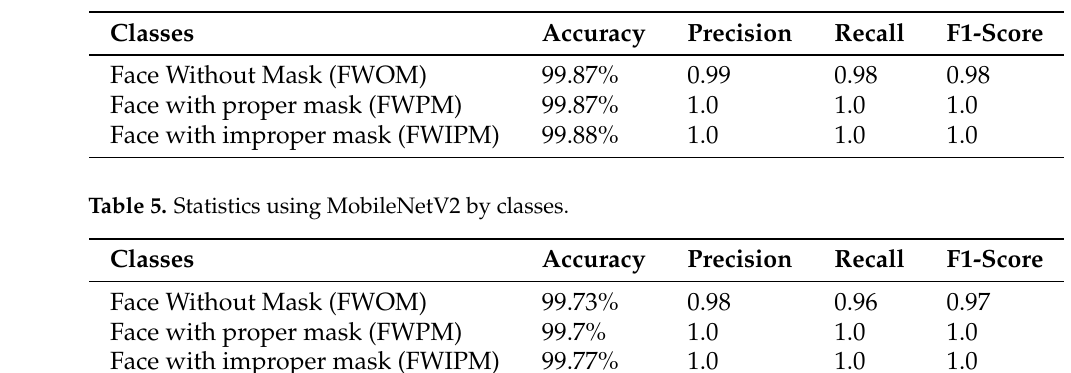
Table 4. Statistics using VGG-16 by classes.